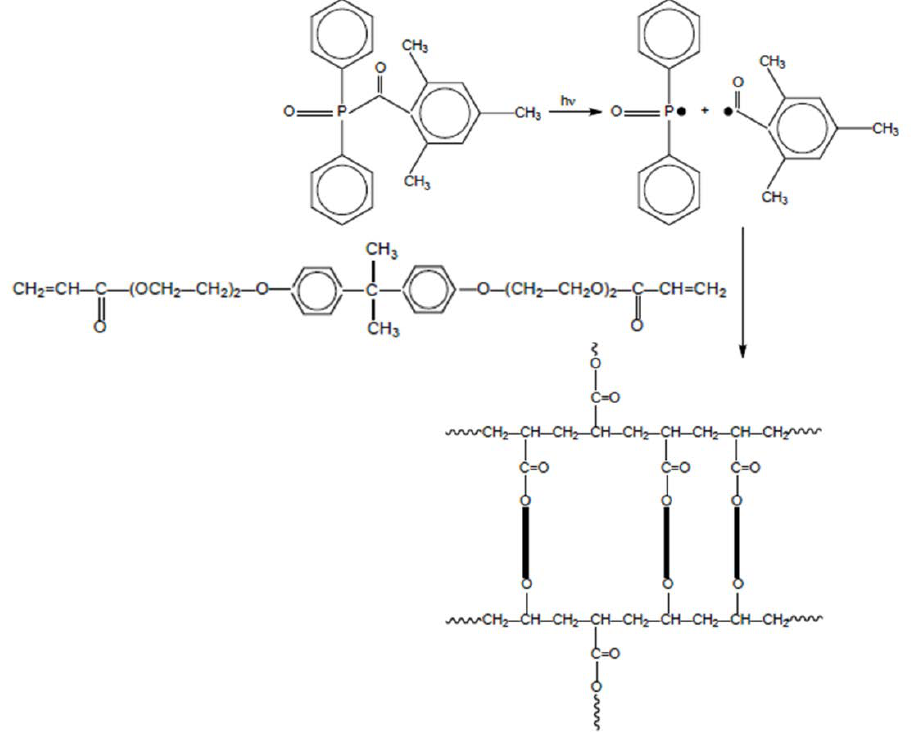
Figure 1. Scheme of UV-LED curing of EB150. The system undergoes a radical polymerization promoted by the generation of primary radicals derived from the photolysis of the photoinitiator as a consequence of the exposure to the UV-LED radiation.